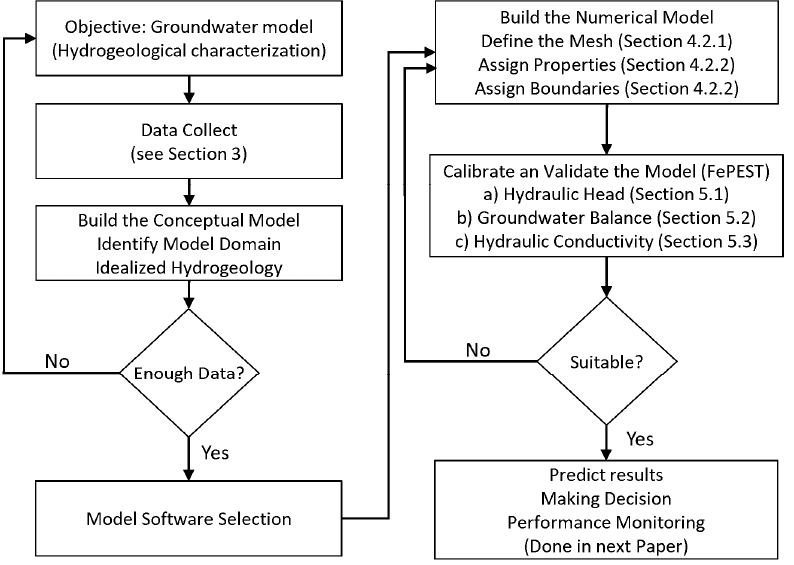
Figure 4. Flowchart of the processing method